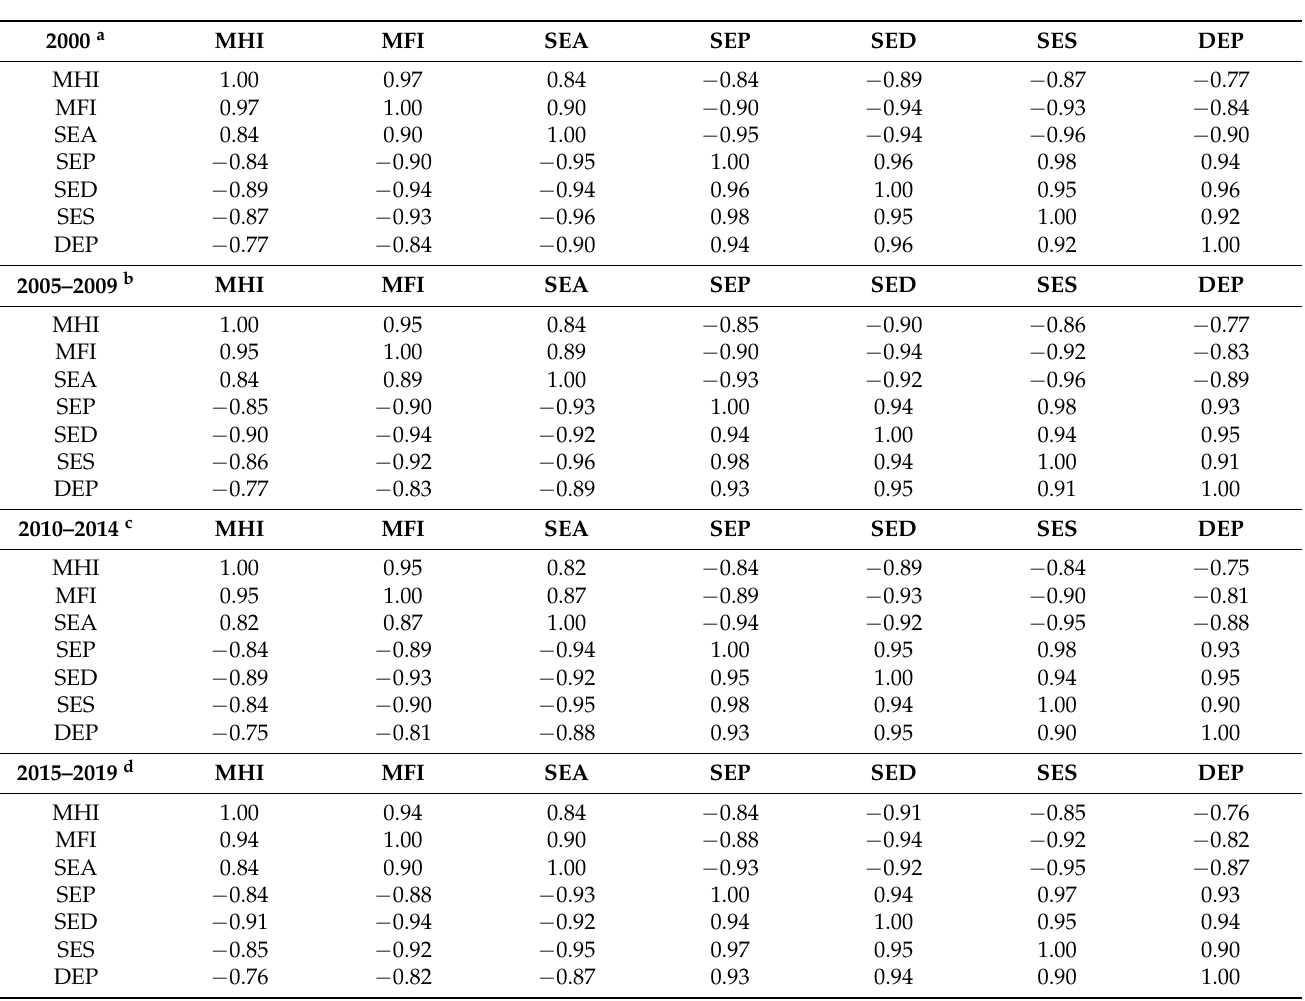
Table 6. Relationships between simple and composite measures of neighborhood socioeconomic status in the Riverside–San Bernardino–Ontario Metropolitan Statistical